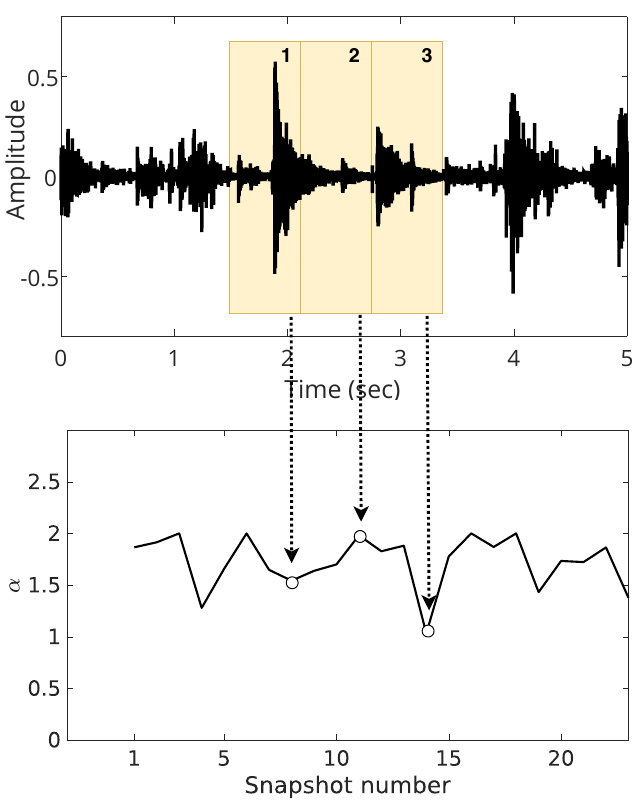
Figure 18. Illustration of non-overlapped